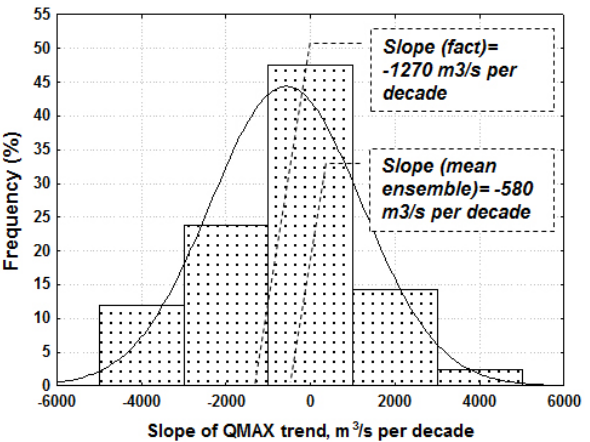
Figure 4. Histogram of the linear trend slope derived from the en- semble of simulated annual maximum discharge time series (line shows fitted normal distribution